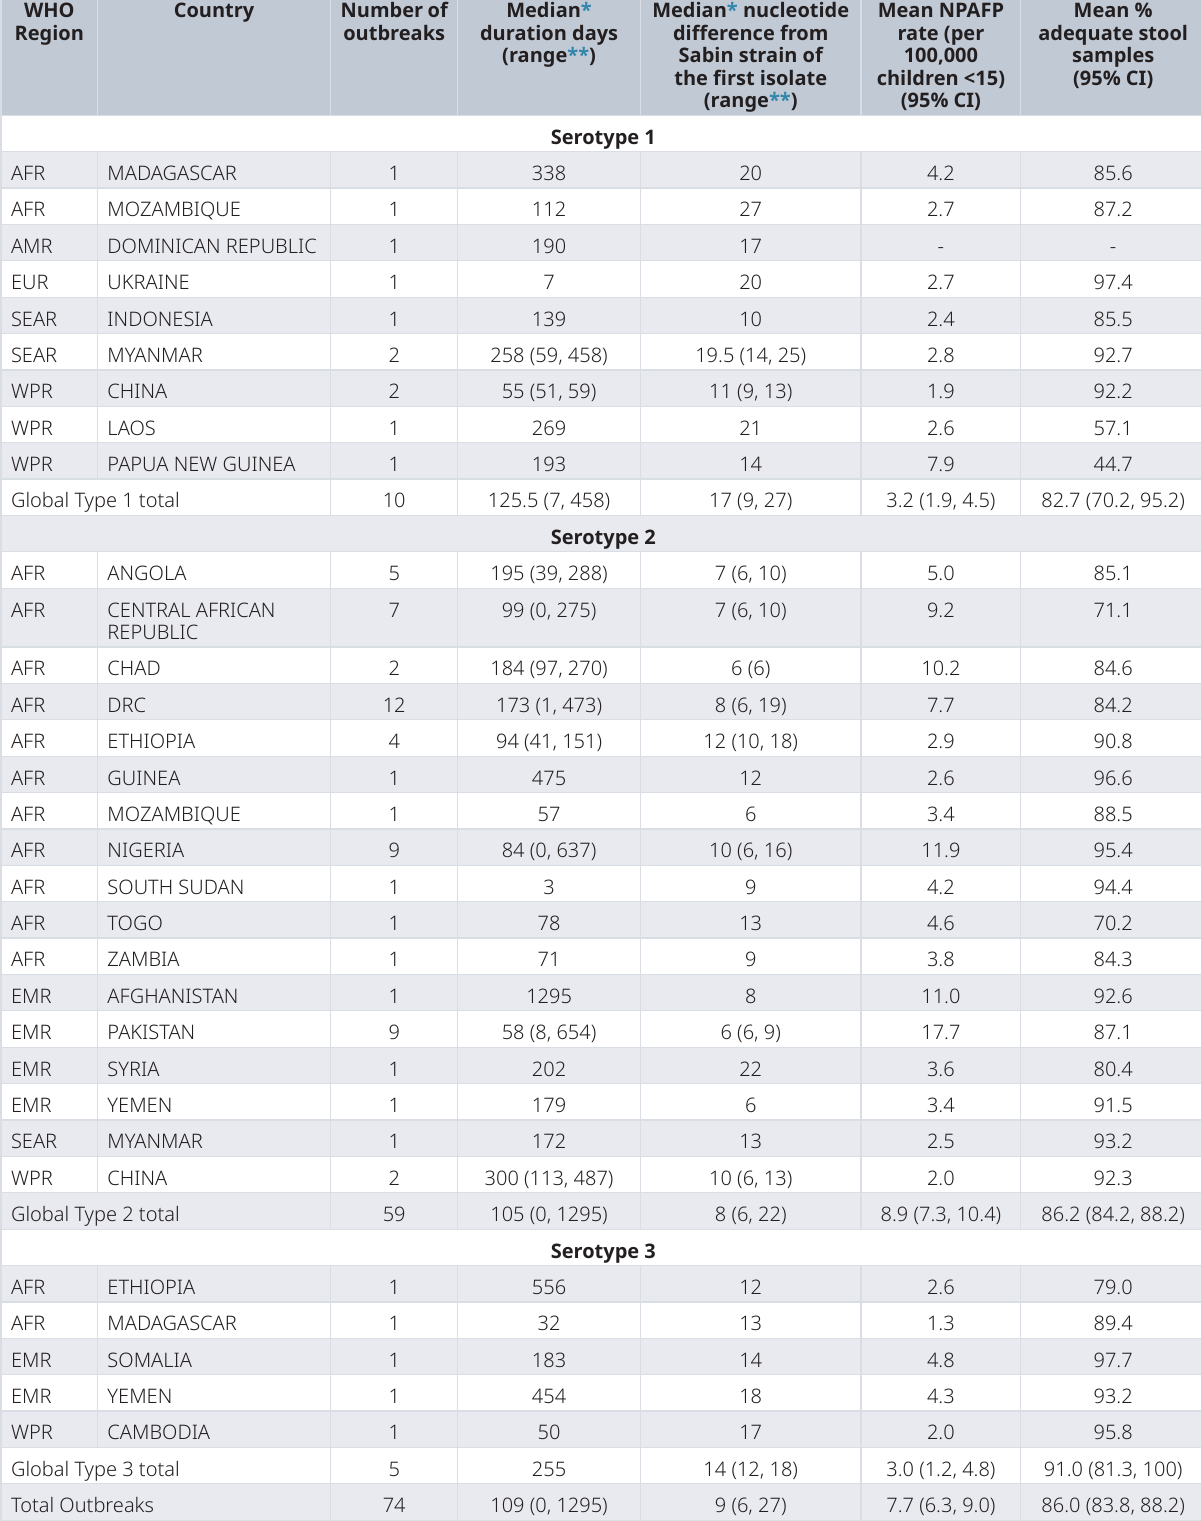
Table 1. Summary of all circulating vaccine derived polioviruses (cVDPVs) included in the analysis split by serotype. WHO=World Health Organization; NPAFP= non-polio acute flaccid paralysis; CI=confidence interval. WHO